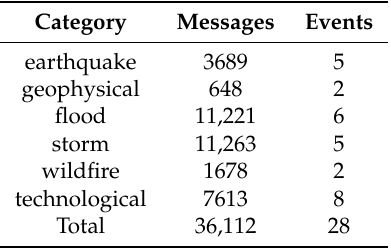
Table 1. Corpus size by